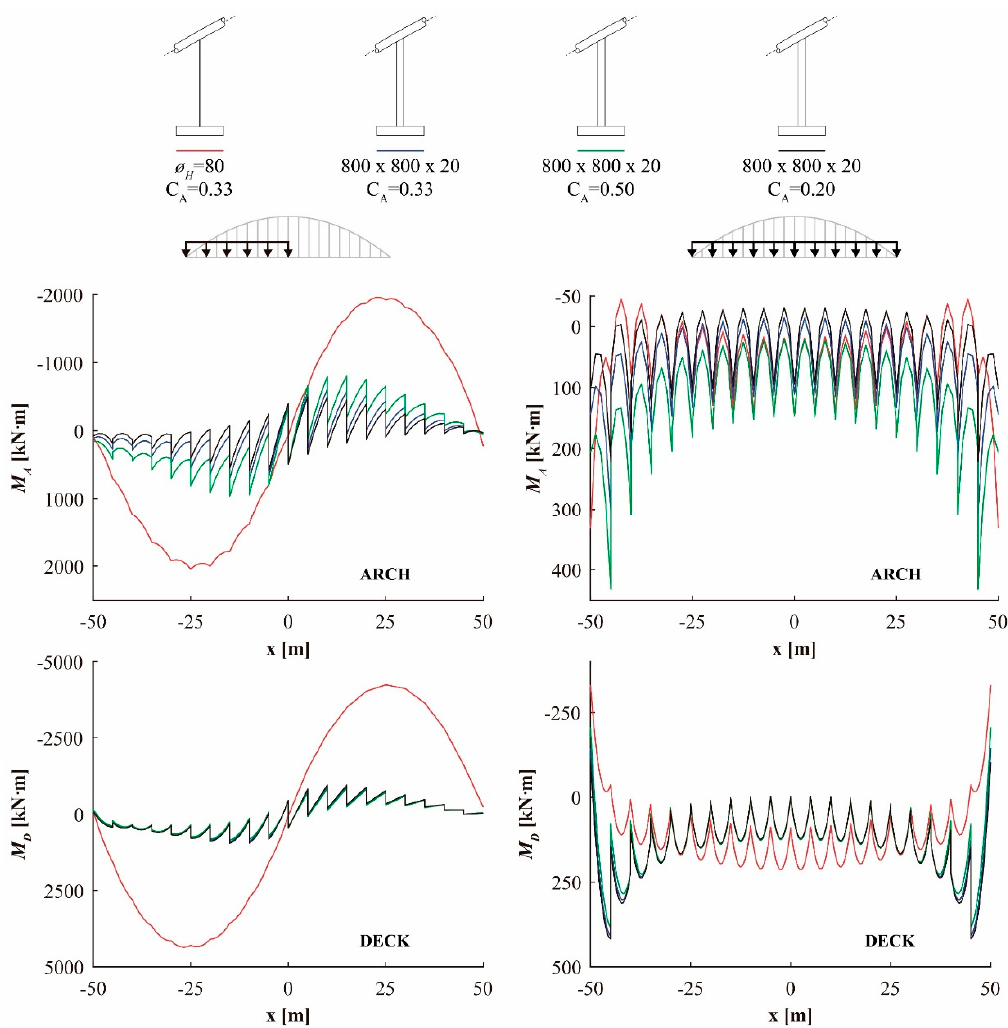
Figure 13. Effect of a Rectangular Hollow Section (RHS) 800 × 800 × 20 mm, for C A = 0.20, 0.33 (reference bridge) and 0.50.